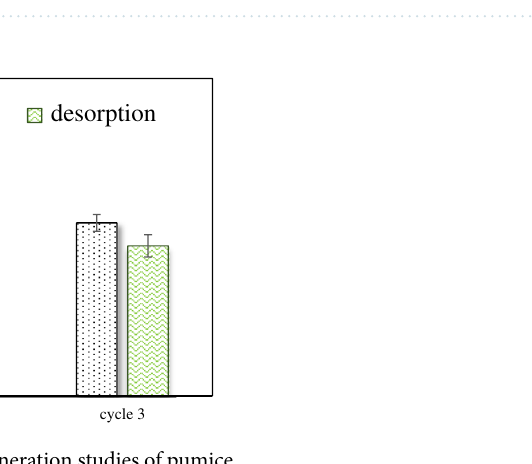
Figure 6. Effect of inorganic salts on diazinon adsorption on pumice (initial diazinon concentration = 6.28 mg/L, pumice dosage = 4 g/L, and contact time = 30 min, electrolyte salt concentration = 500 mg/L).